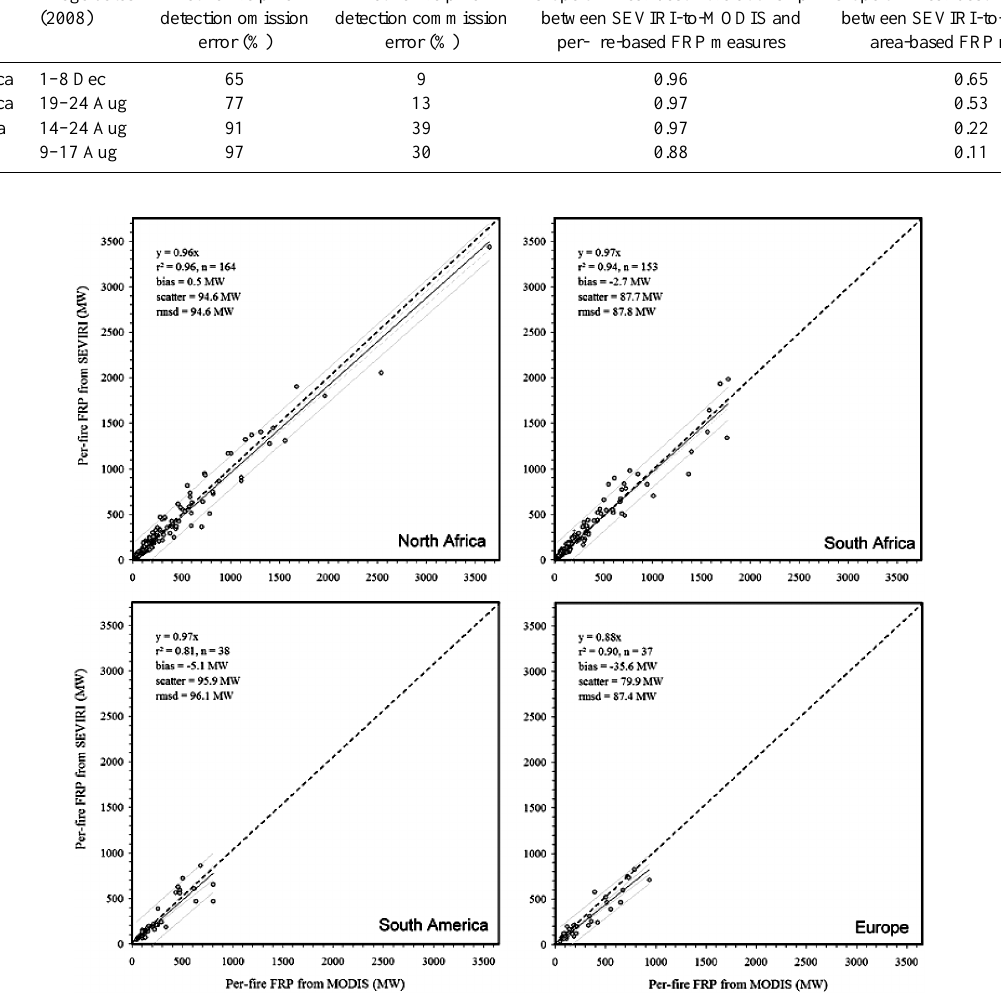
Figure 2. A comparison of per-fire FRP derived from SEVIRI and MODIS observations of fires observed near-simultaneously by each sensor during 1 week in each LSA SAF geographic region (Fig. 1). Fires are designated as contiguous clusters of active fire pixels. SEVIRI FRP is taken from the LSA SAF FRP-PIXEL product in each case and MODIS FRP is taken from the MOD14 product (Collection 5; Giglio et al., 2003). The most radiant fires were detected in the Northern Africa region (top left), and all regions are displayed on the same x and y axis scales for ease of